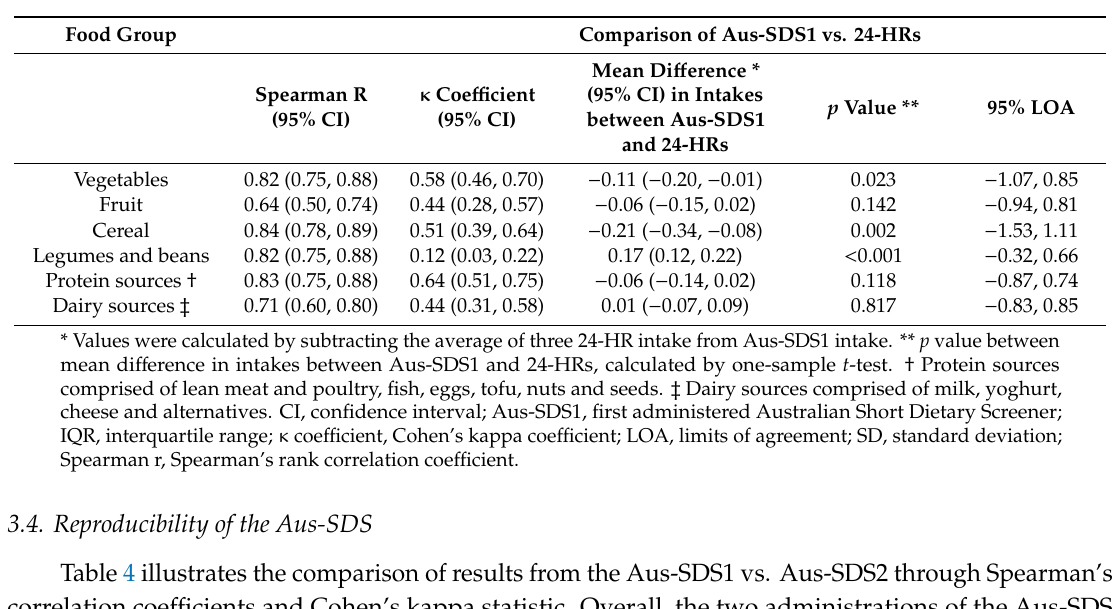
Table 3. Relative validity of the Aus-SDS1, determined by comparison of intakes assessed in Aus-SDS1 and the average of